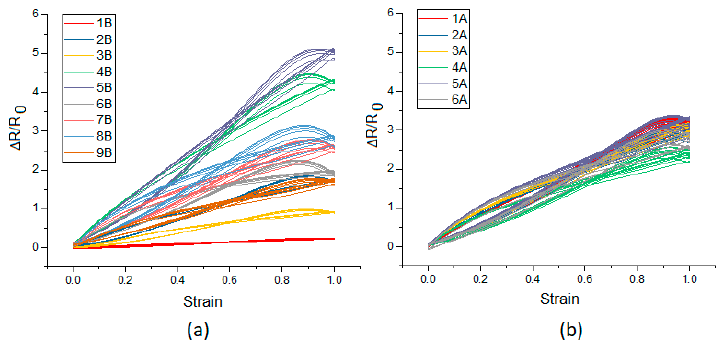
Figure 2. Plots showing the relationship of the change in resistance ( Δ R/R) with strain for different sensors fabricated with ( a ) “layer-upon-layer” and ( b ) “embedded” printing, over 5 repeated stretch cycles.